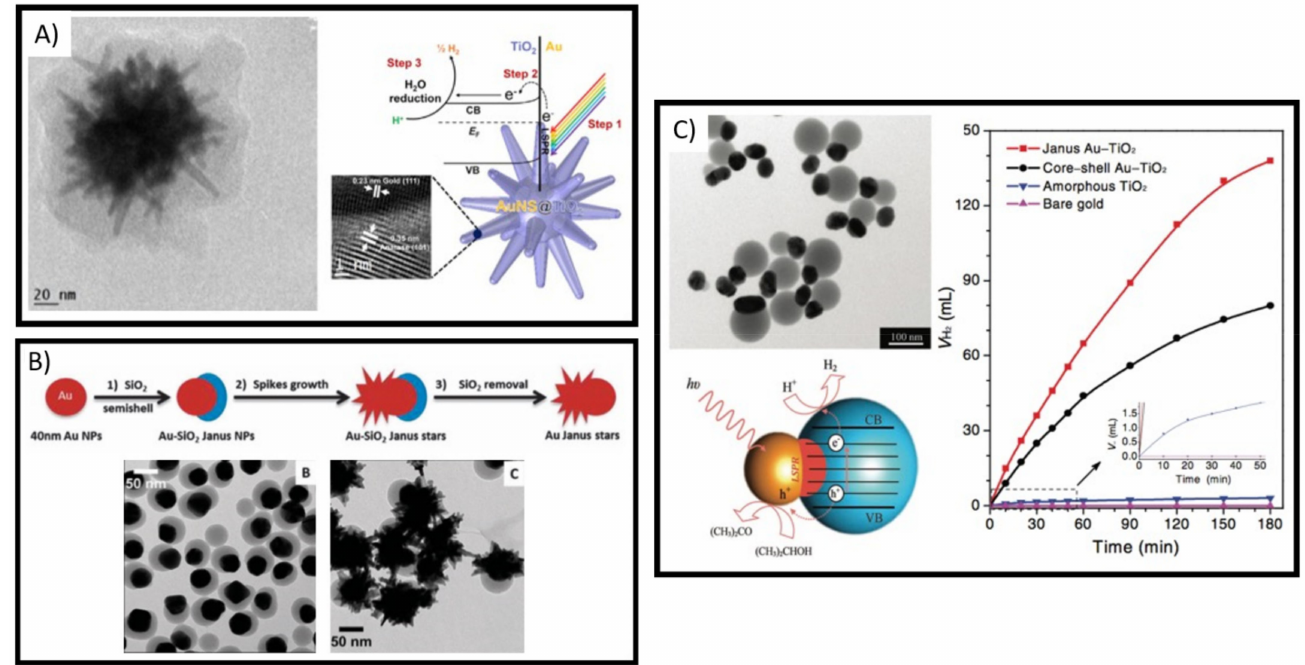
Figure 10. Complete hybrid Plasmonic NPs-TiO 2 system with sizes at the nanoscale can be achieved. ( A ) Core-shell made of anisotropic plasmonic NPs coated by crystalline TiO2 layers can perform as good visible light-driven photocatalysts. Adapted with permission from Atta et al. Chem. 2018, 4, 2140–2153 Copyright 2018, Elsevier Inc. [100]. ( B ). Colloidal synthesis methods allow breaking the symmetry of plasmonic NPs and even obtaining anisotropic Janus-like NPs. Adapted with permission from Rodriguez-Fernandez et al. Chem. Commun. 2014, 50, 79–81 Copyright 2014, Royal Society of Chemistry [101]. ( C ). Non-centrosymmetric Janus Au-TiO 2 NPs can be synthesized with excellent visible light photocatalytic activity. Adapted with permission from Seh et al. Adv. Mater. 2012, 24, 2310–2314 Copyright 2012, WILEY-VCH Verlag GmbH & Co. KGaA Weinheim